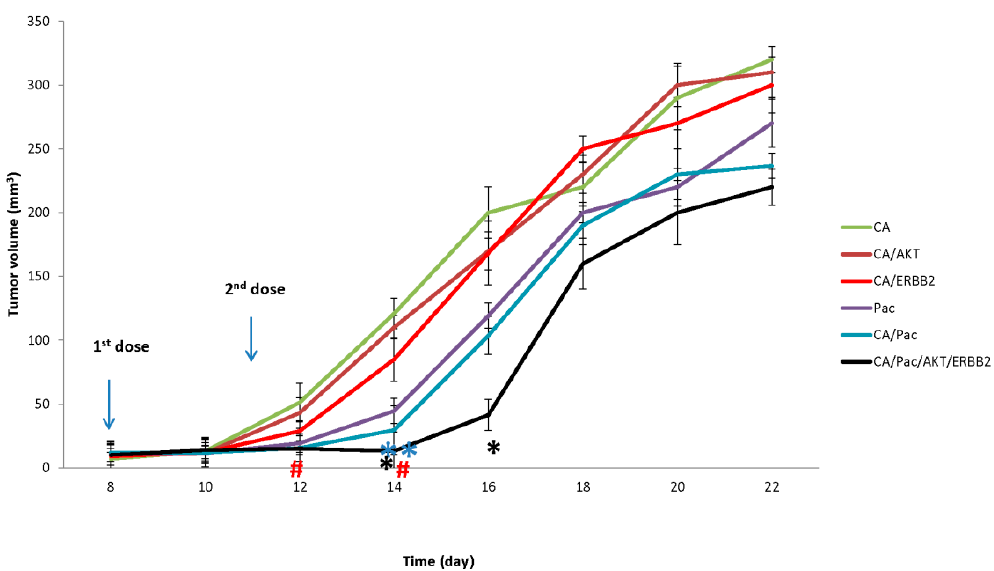
Figure 6. Effect of silencing AKT and ERBB2 pathways on in vivo efficacy of paclitaxel. Mice were purchased from Razi Research Institute, Tehran, Iran. Approximately 10 6 4T1 cells were inoculated subcutaneously on the mammary pad of mice. Based on tumor volume calculations, mice were randomized and treated intravenously through tail-vein injection on day 8 and 11. The therapeutics included 100 μ L of carbonate apatite entailing 4 μ L of 1M CaCl 2 and 50 nM of AKT and ERBB2 siRNA plus 1.25 mg/kg Pac. Body weight and tumor outgrowth were monitored every other day. Data is represented as mean ± SD, n = 6 and values are significant when * p value < 0.05 for CA/Pac/AKT/ERBB2 vs. CA/Pac, # p value < 0.05 for CA/ERBB2 compared to CA and ** p value < 0.05 for CA/Pac against Pac.